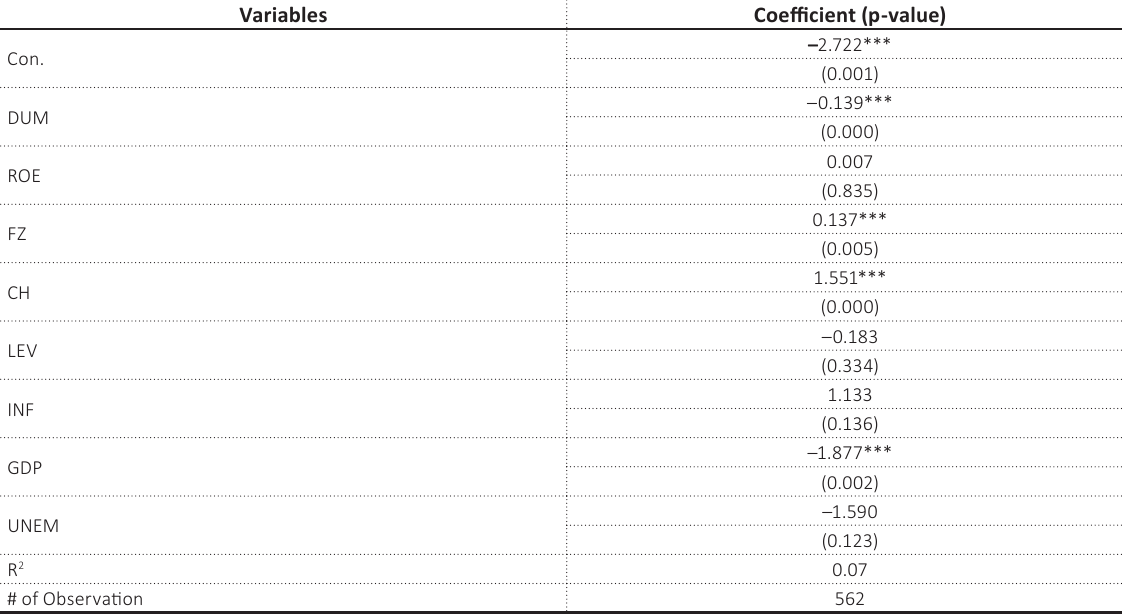
Table 8. Corporate immunity to the accumulated COVID-19 pandemic Variables